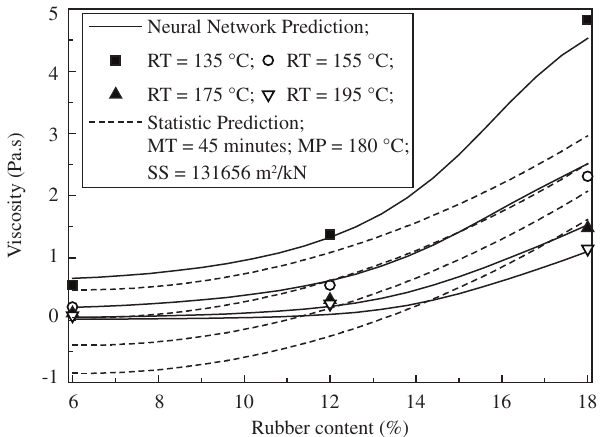
Figure 7. Dependence of viscosity from rubber content and read tempera- ture.